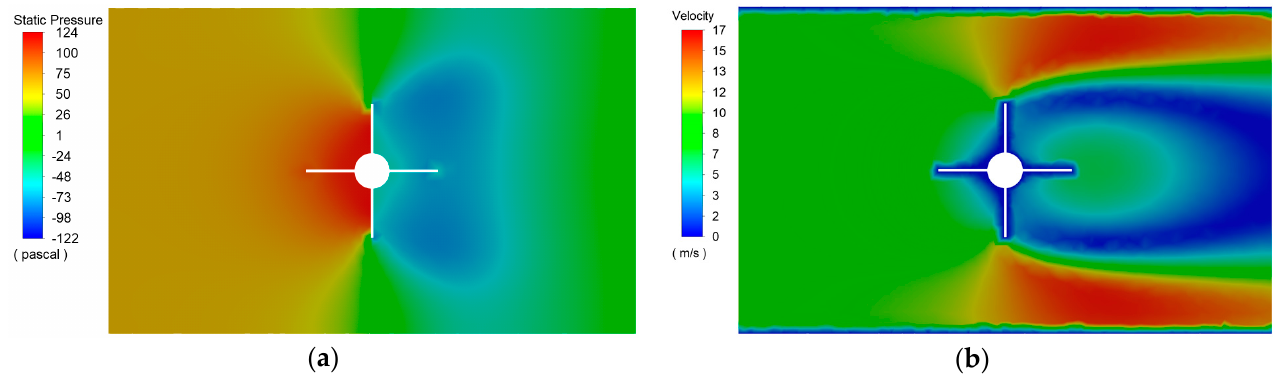
Figure 10. ( a ) Pressure distribution; ( b ) Velocity distribution for the tube with 2 fins (case c2).